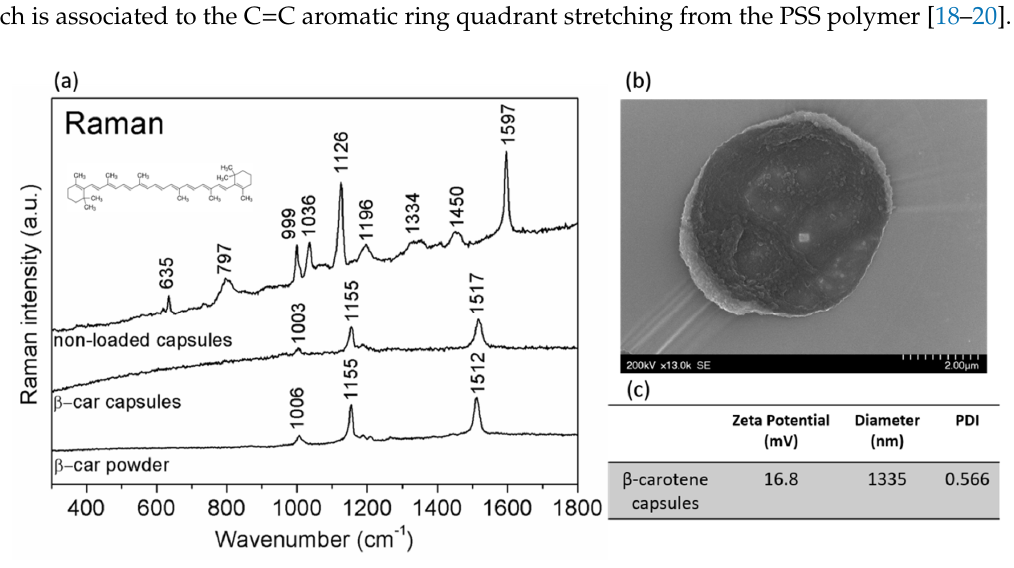
Figure 1. ( a ) From top to bottom, Raman spectra of empty polyelectrolyte multilayer (PEM) capsules, beta-carotene PEM capsules, and beta-carotene powder; ( b ) SEM image of one PEM capsule; ( c ) zeta